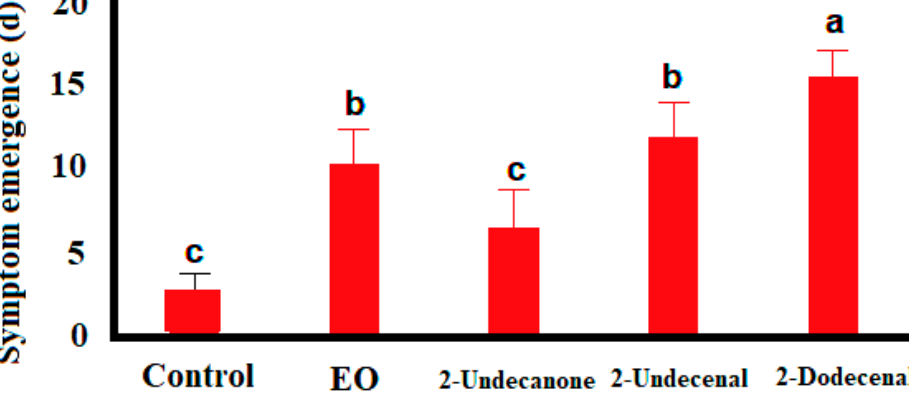
Figure 4. Average time for rot symptom emergence in manzano peppers infected with Fusarium temperatum (control) and effect of the in situ application of 120 mg L − 1 ZlEO, 150 mg L − 1 2-undecanone, 220 mg L − 1 2-undecenal, and 130 mg L − 1 2-dodecenal on infected peppers during 16 d. Means (n = 20) with different letter indicates statistically significant differences by ANOVA-Tukey-Test ( p < 0.05).